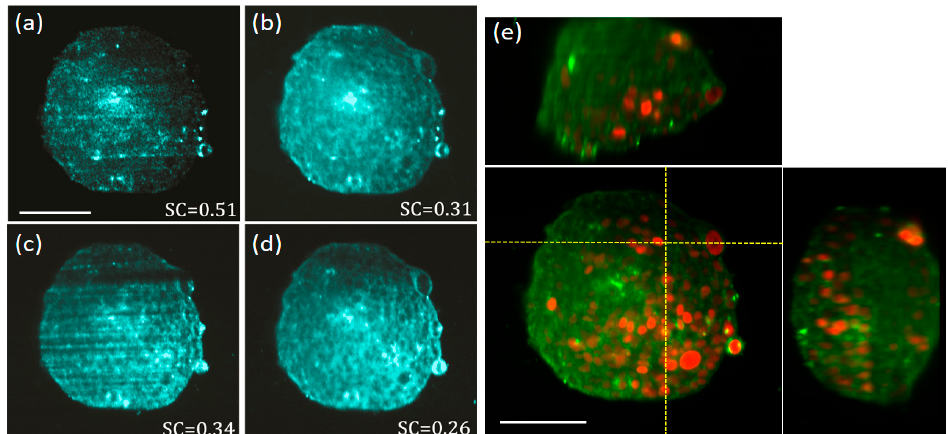
Figure 4. Elastic scattering light sheet imaging of a multicellular tumour spheroids (MCTS) with fluorescently labelled nuclei. Polarization was set to horizontal-IN horizontal-OUT configuration. Elastic scattering images of a single optical section of the MCTS obtained by using: ( a ) a diode laser (high temporal coherence) emitting at 638 nm and a static illumination light sheet, ( b ) the same diode laser of (a), but with the light sheet pivoting at 100 Hz with respect to the centre of the FOV, ( c ) a SCL (low temporal coherence) emitting a broadband spectrum of 140 nm (centred at 600 nm) and a static illumination light sheet, and, ( d ) a SCL as in (b) but the with light sheet pivoting at 100 Hz with respect to the centre of the FOV. ( e ) 3D orthogonal views (centre panel front-view, top panel top-view, right panel side-view), of the same MCTS sample where the fluorescent nuclei (red) and the elastic scattering data (green), obtained with the SCL and the pivoting light sheet, are merged together for comparison. The MCTS nuclei are labelled with the mCherry fluorescent protein. Laser powers at the back of OBJill are 3 mW and 1 mW for elastic scattering and fluorescence imaging modalities, respectively. Scale bars 100 µ m.